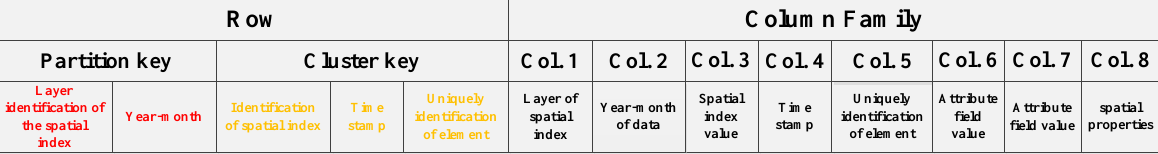
Figure 3. Structure of vector data table